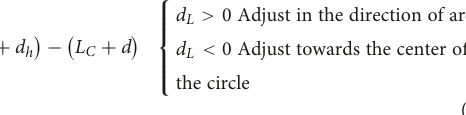
in Equation (5). When d L < 0, the arc array moves along the edge navigation sensor module toward the direction of detecting the center of the arc; when d L > 0, the arc array moves along the edge navigation sensor module toward the detection arc direction.